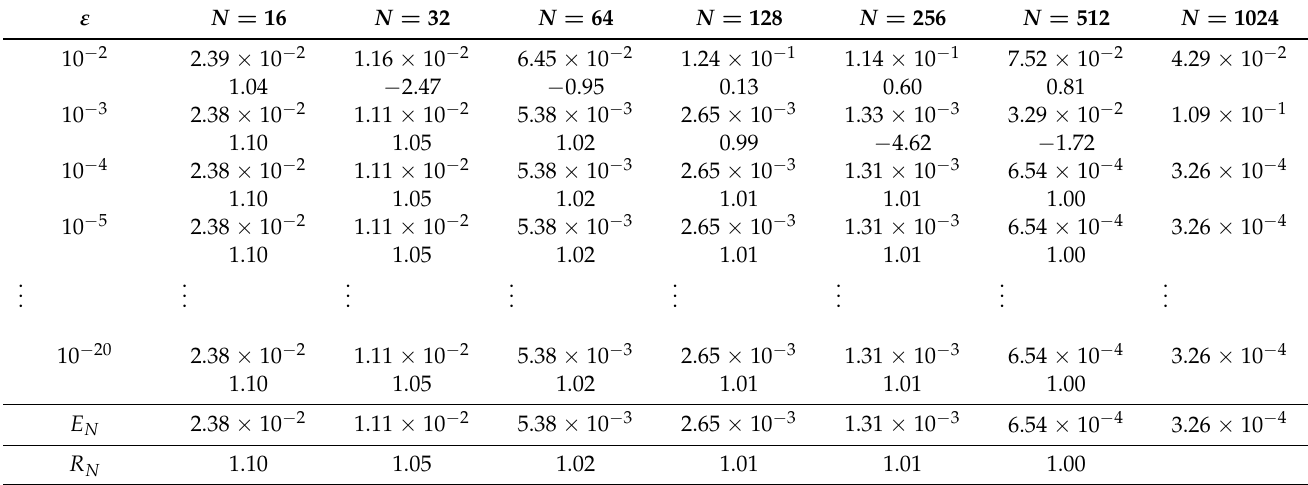
Table 3. Results for Example 3: maximum errors and convergence rate for